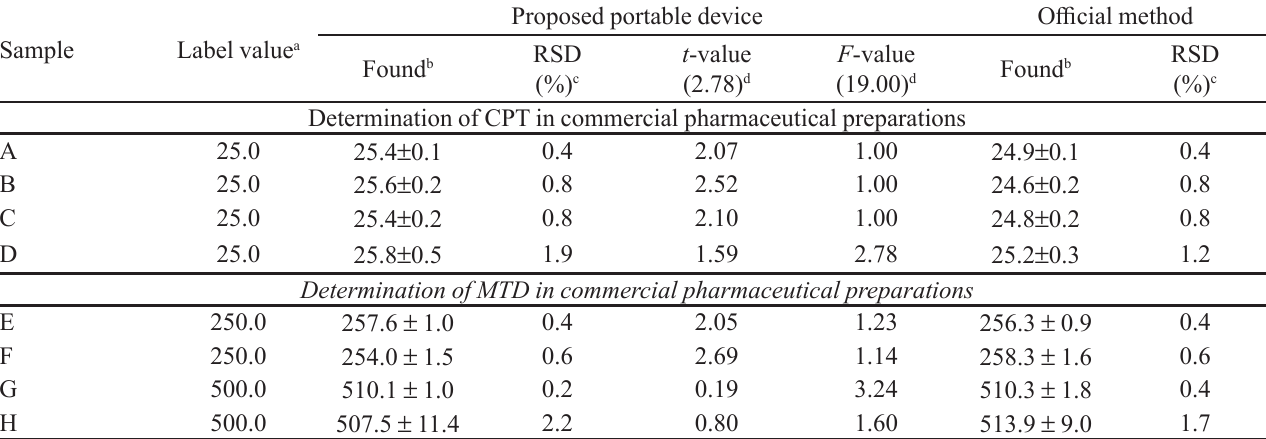
TABLE I - Results of CPT and MTD assays in tablets